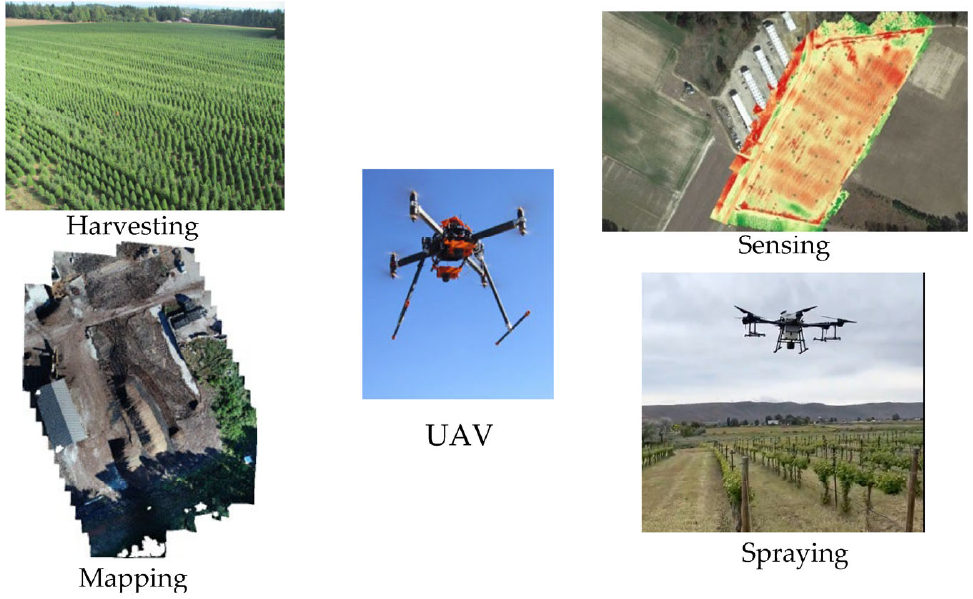
Figure 1. Multiple application of UAV in Agriculture.